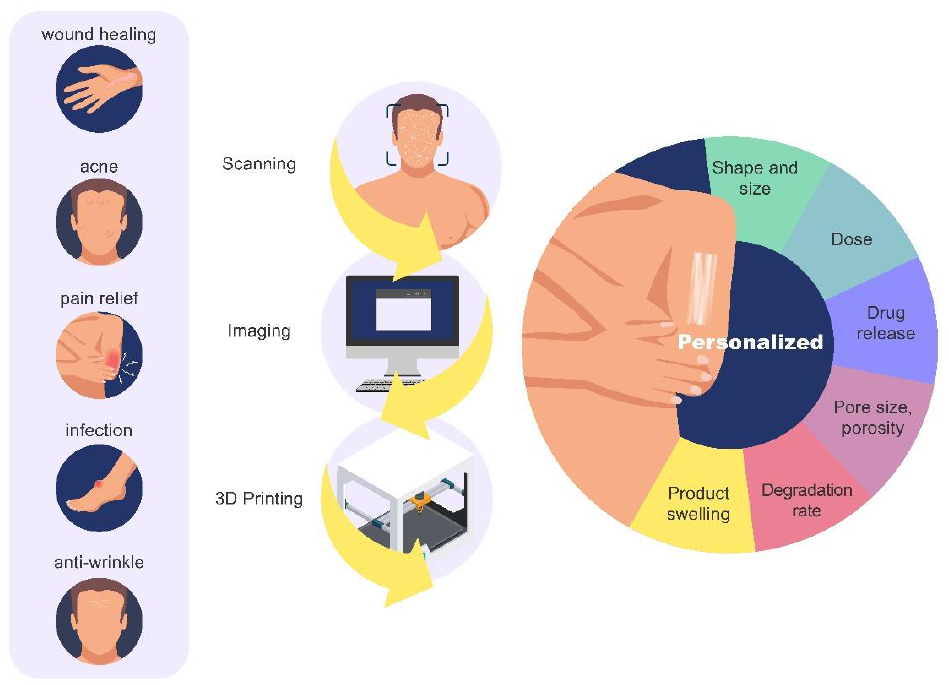
Figure 4. Main applications and advantages of 3D printing for topical skin products.